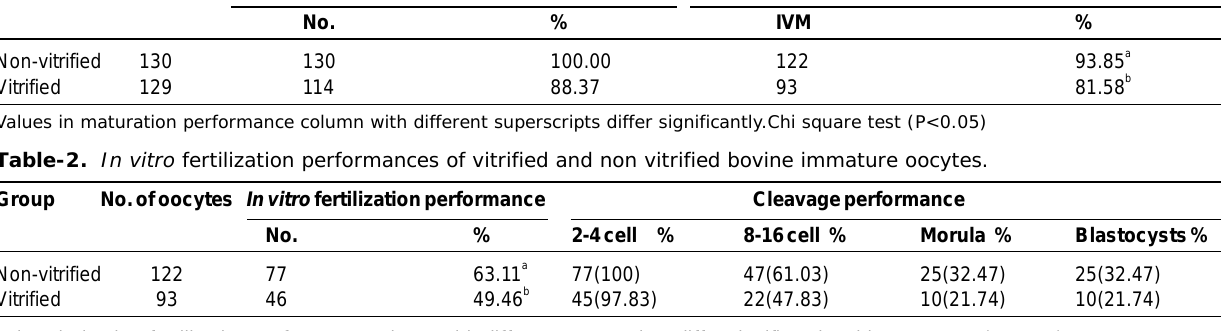
Table-1. Effect of cryoprotectants exposed / vitrified immature oocytes on survival percentagr and maturation in vitro Group